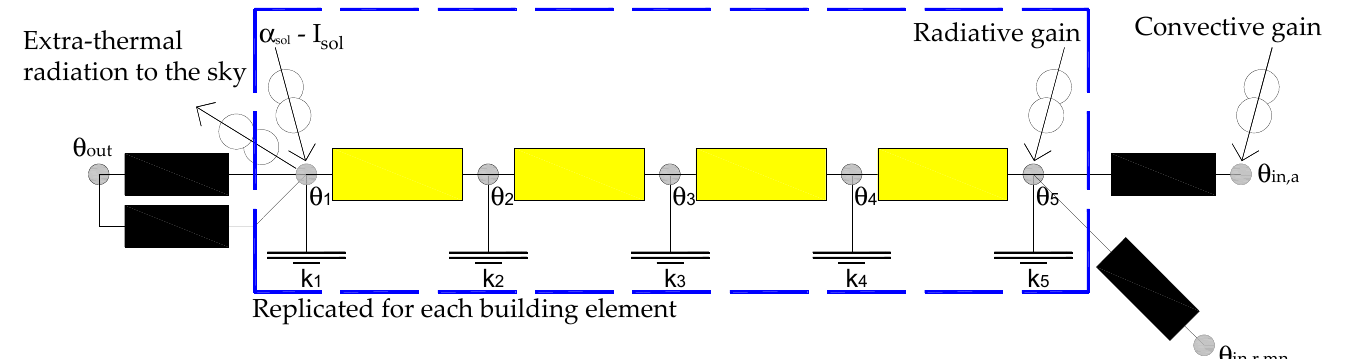
Figure 3. Re-elaboration of the scheme of resistance and capacitor (RC) network thermal model provided by UNI EN 52016 [32].